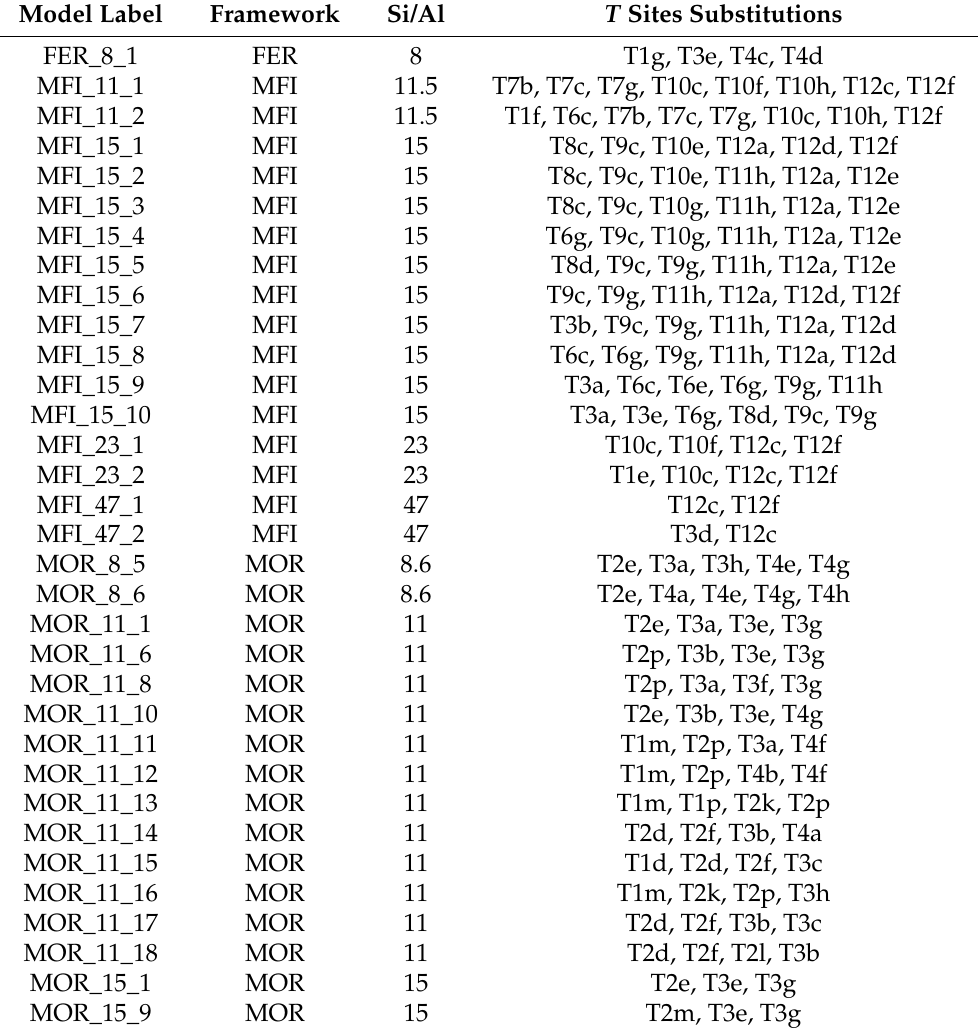
Figure 2. MOR ( left structure ) and FER ( right structure ) unit cell with labelled T sites. Table 2. Considered Al substitution positions in the FER, MFI, and MOR model unit